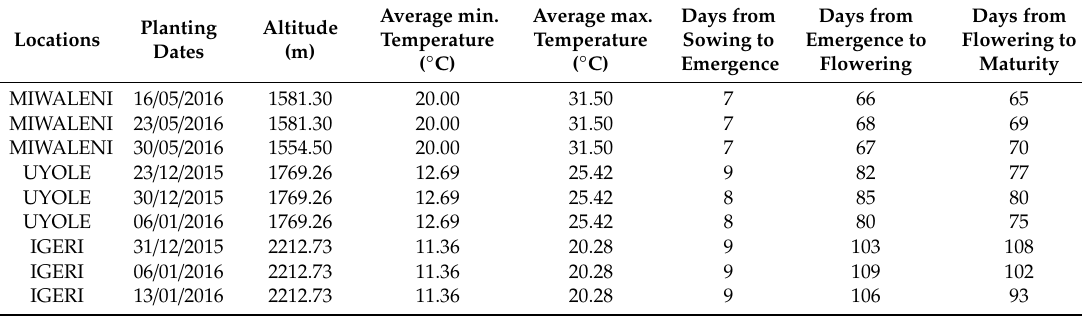
Table 4. Summary of the number of days from sowing to emergence, emergence to flowering and flowering to maturity respectively; for MERU HB 513 type hybrid maize variety for 3 planting dates in 3 locations of